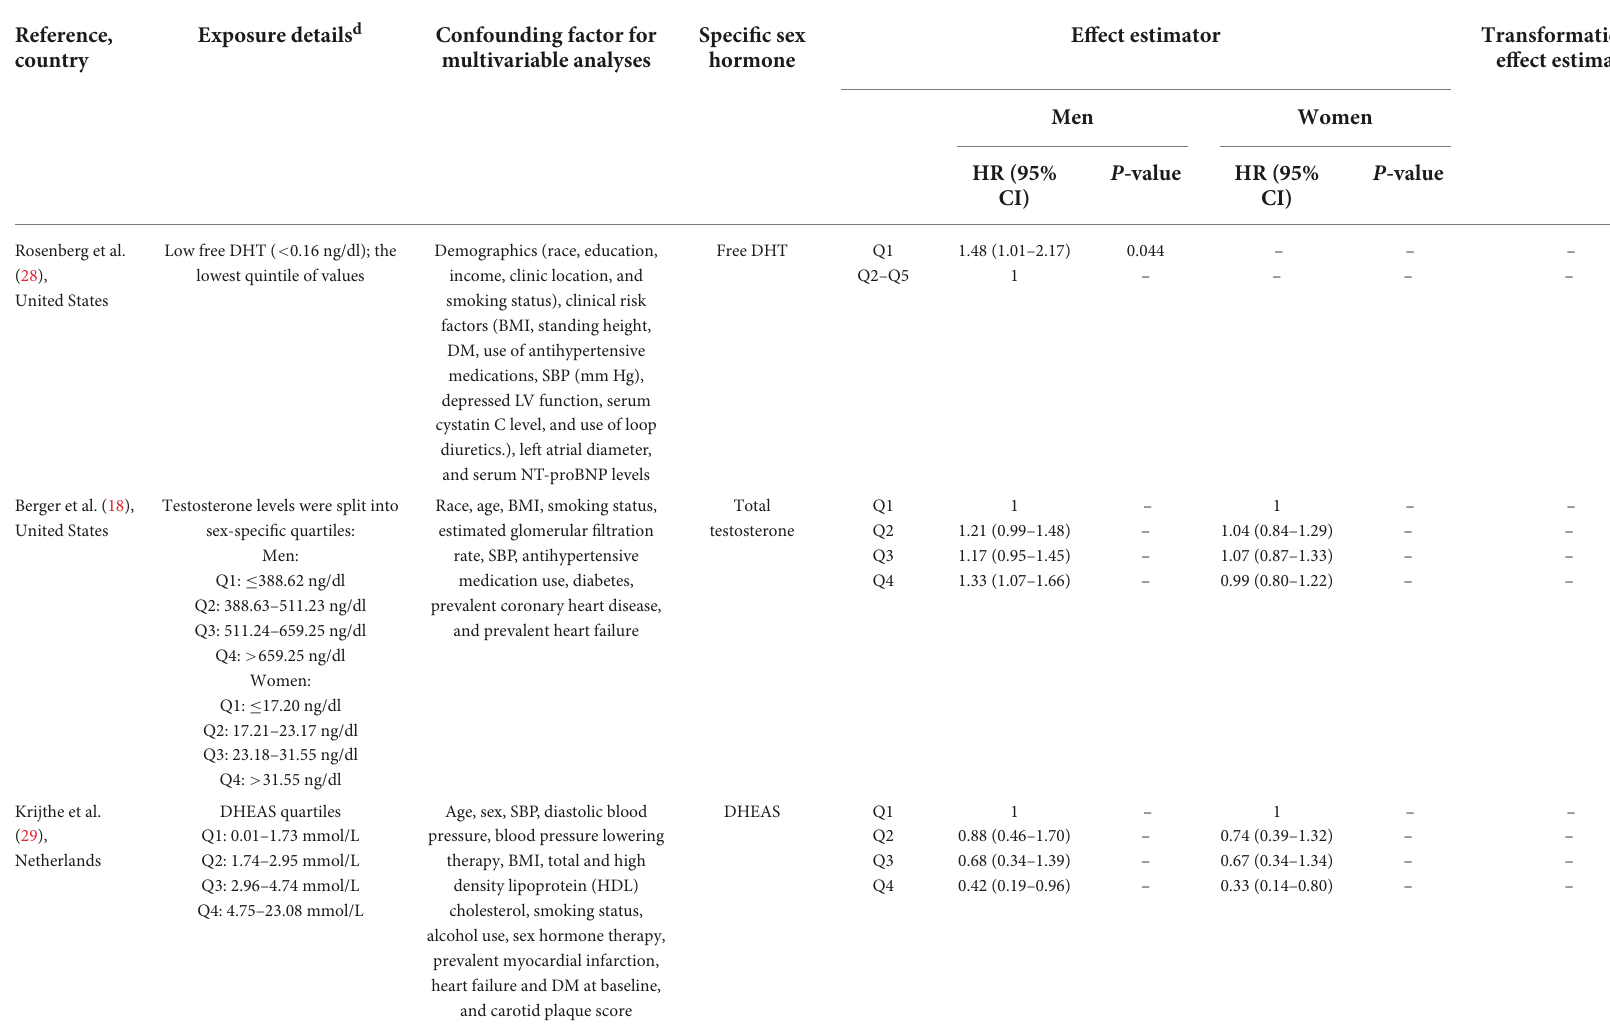
TABLE 3 Main sex hormones measured in the included cohort